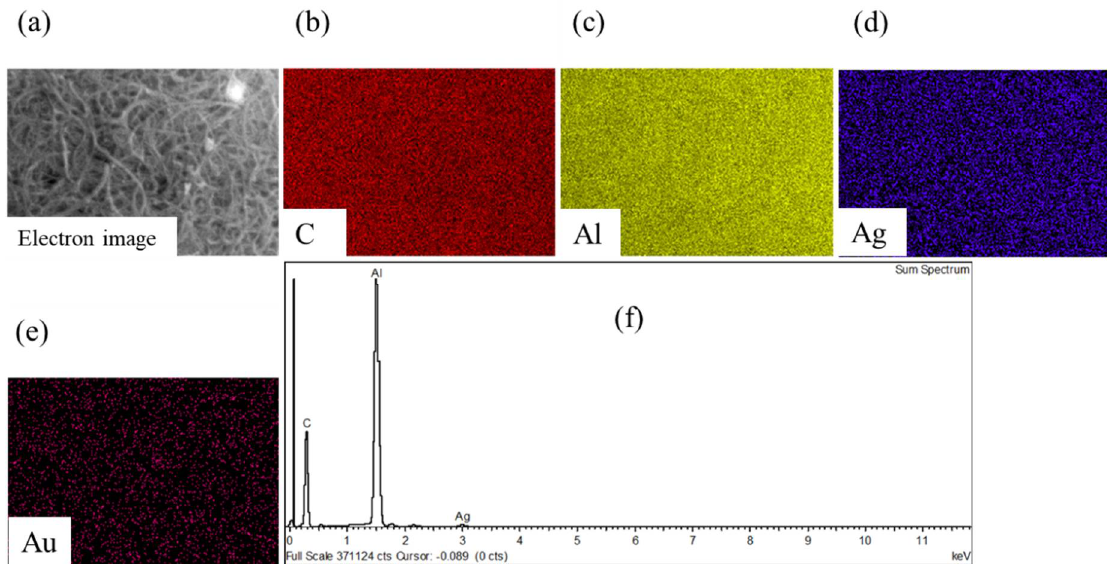
Figure 7. ( a ) Electron beam microscopy image of MWCNT-Ag powder; ( b ) signal of carbon from MWCNTs; ( c ) signal of aluminum from sample holder; ( d ) uniform dispersion of Ag particles within the MWCNT network; ( e ) signal of gold from conductive coating; ( f ) EDX spectrum showing dispersion of Ag particles with MWCNT powder.